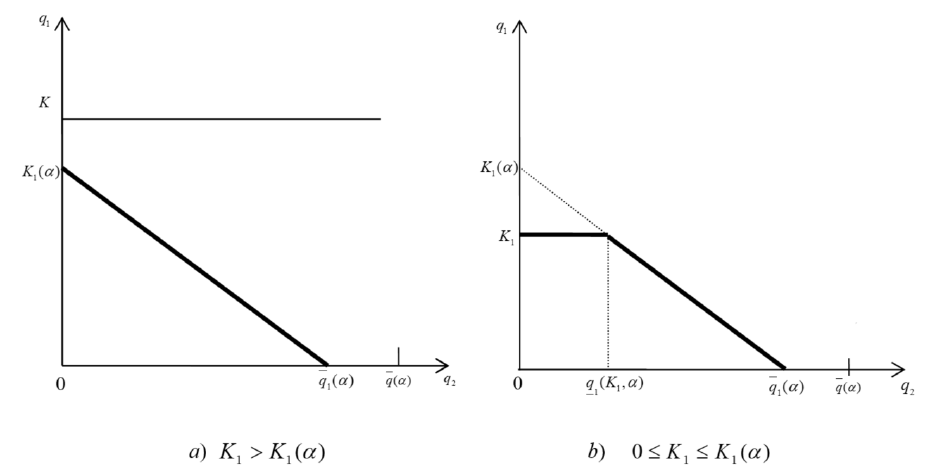
Figure A1. Best Response of Firm i in Market α > β